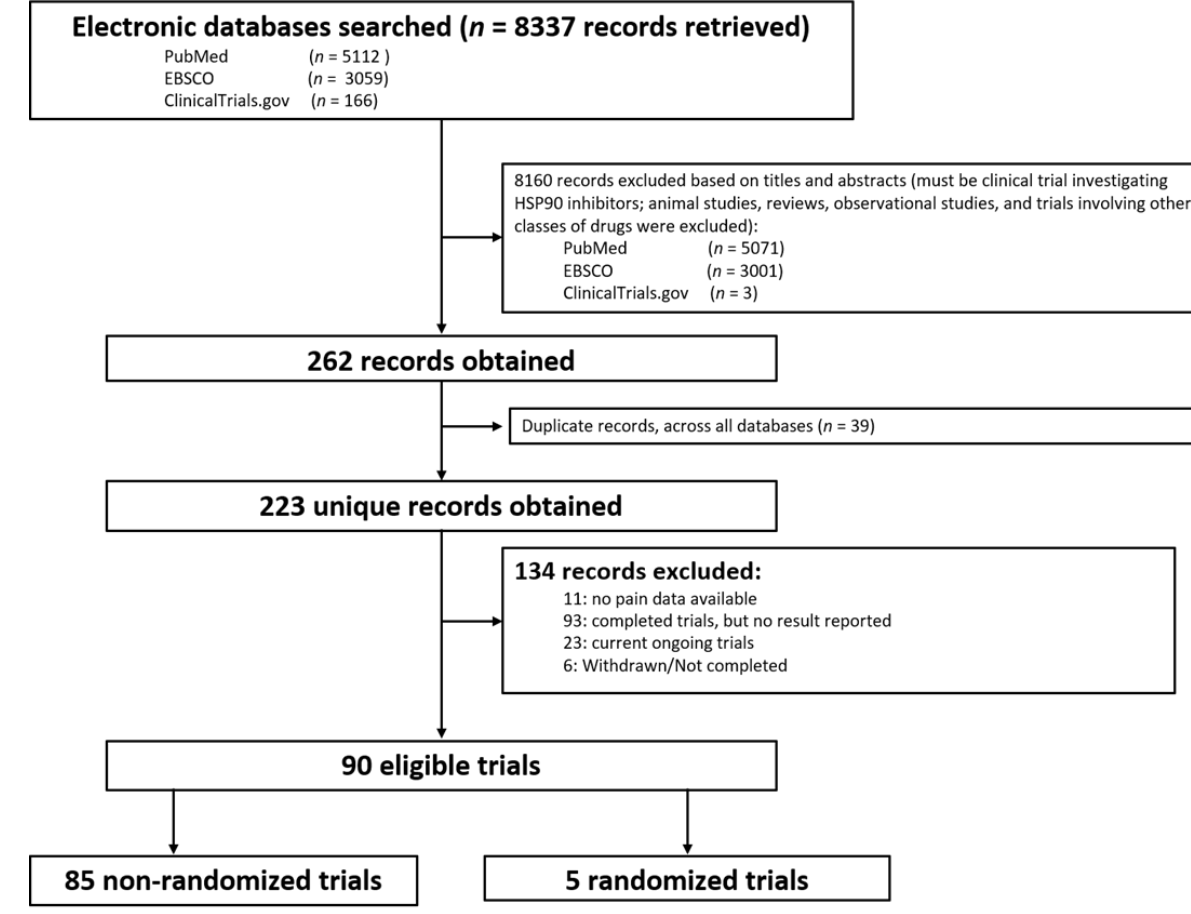
Figure 1. Flow diagram of identification of eligible trials.